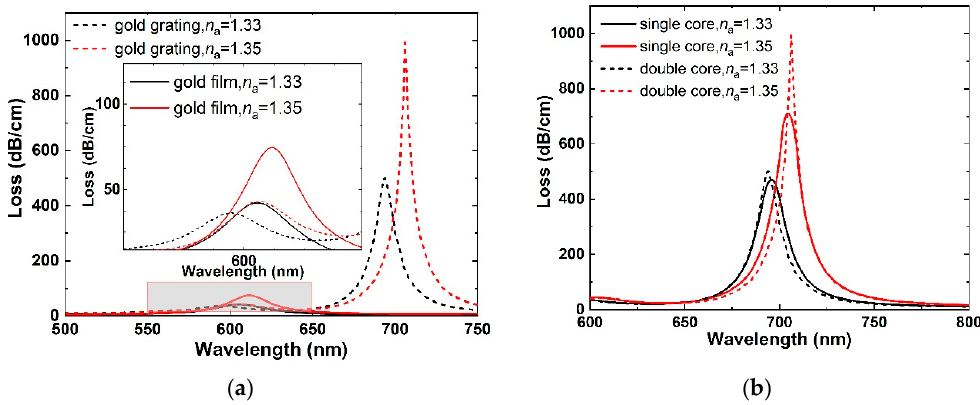
Figure 4. ( a ) Wavelength-dependent loss spectra of gold grating and gold film with refractive index from 1.33 to 1.35, and ( b ) Wavelength-dependent loss spectra of single-core and dual-core with refractive index from 1.33 to 1.35.